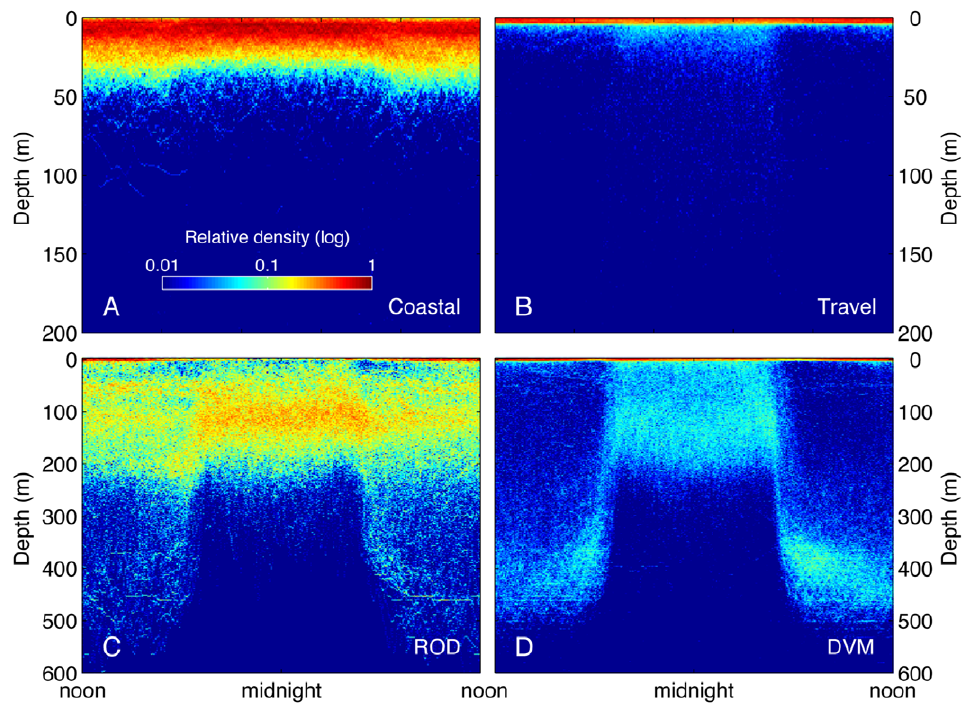
Figure 3. Diel patterns of white shark diving behavior from archival records queried by cluster. High-resolution time and depth data were corrected for local time and aggregated by cluster over a 24-hour period. The relative density of data (log scale) is shown on a gridded surface for the four dominant clusters ‘Coastal’ (A), ‘Travel’ (B), ‘ROD’ (C), and ‘DVM’ (D) representing 97.9% of data. The clusters differed not only by overall daily depth distribution, but also in the diel pattern of depth occupancy. Note that a faint signal of DVM dive pattern can be detected in the other clusters. This is likely because sharks switched between behaviors at arbitrary times of day while the data were divided in regular 24-hour bins, resulting in some ‘bleeding’ of the behavior across clusters.